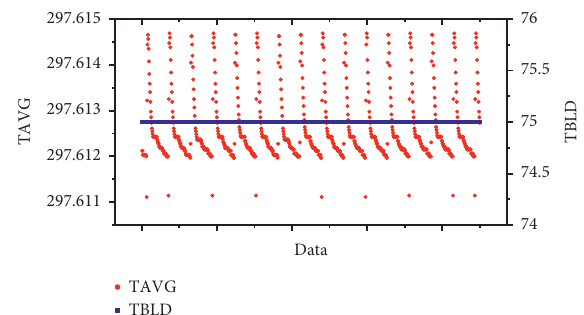
Figure 5: Data with the class label of “75% power” in experiment